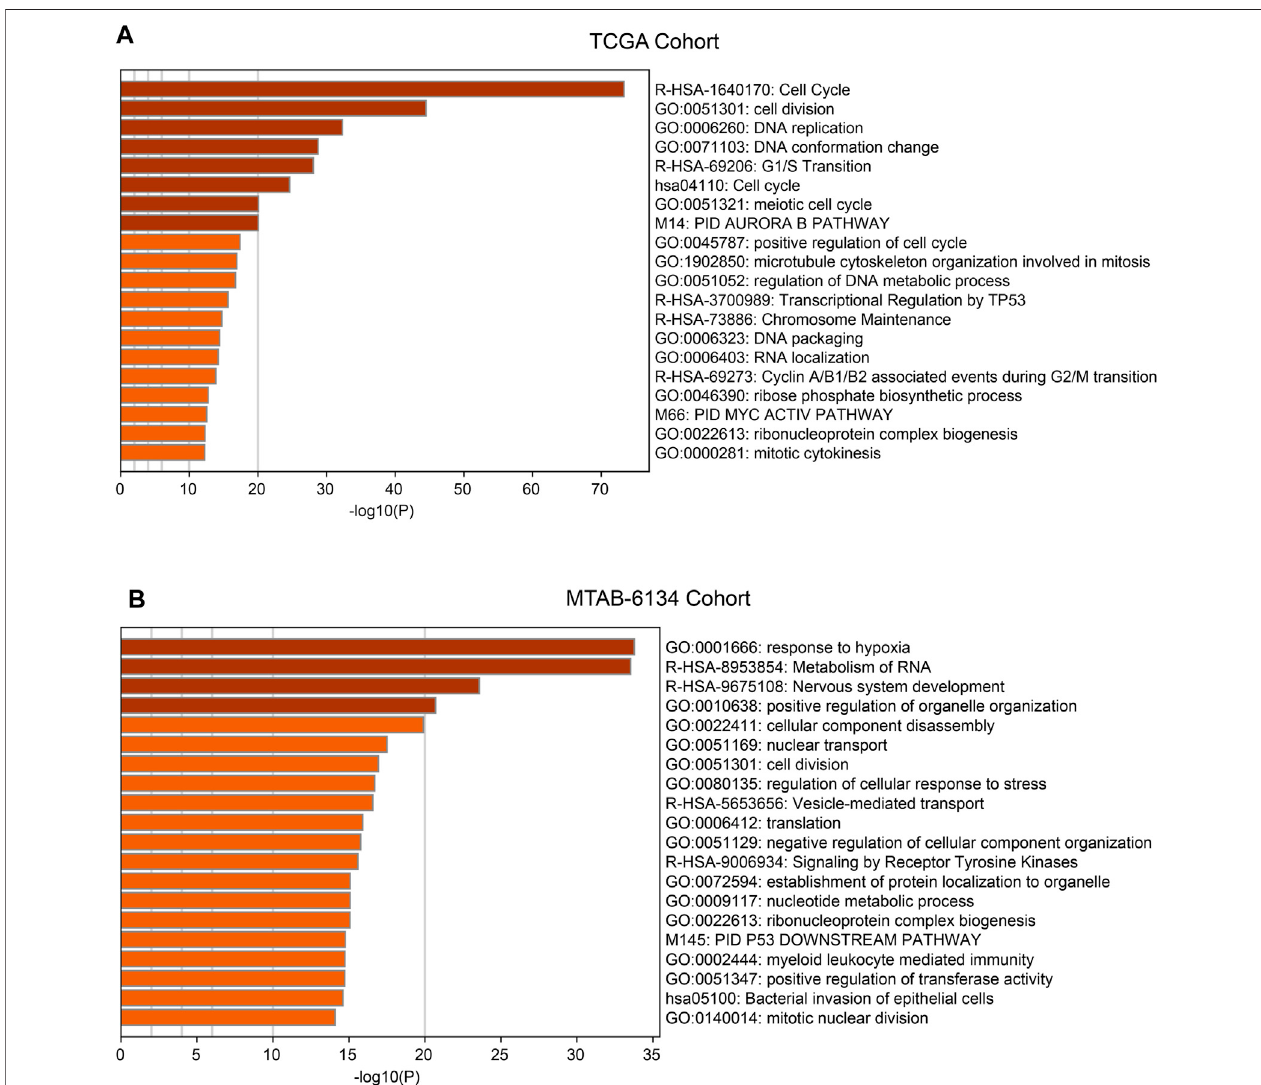
FIGURE 6 | Functions and pathways of the ferroptosis-related signature. (A) Functional annotation and pathway enrichment analyses of top 1,000 positively corelated genes of risk model in TCGA cohort. (B) Functional annotation and pathway enrichment analyses of top 1,000 positively corelated genes of risk model in MTAB-6134